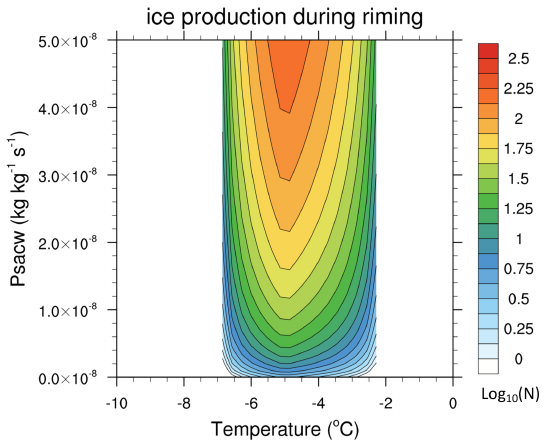
Figure 3. The rime splintering rate (shown as log 10 N ) as a function of temperature and riming